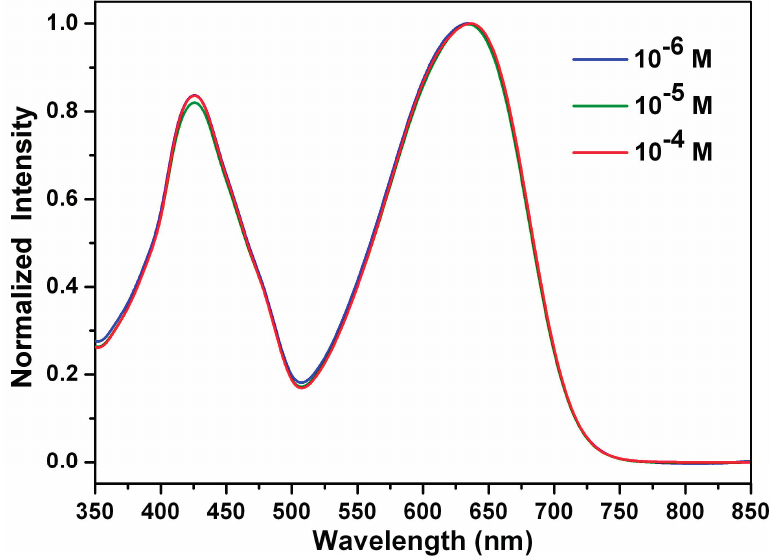
Figure 9. Normalized absorption spectra of 1a at different concentrations in ethyl acetate.